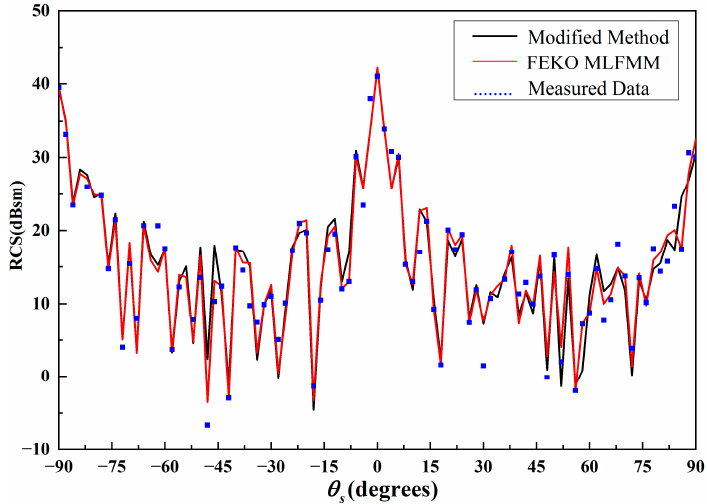
Figure 4. Mono-static RCS for HH polarization of four hybrid dielectric and conductor cubes in free space.